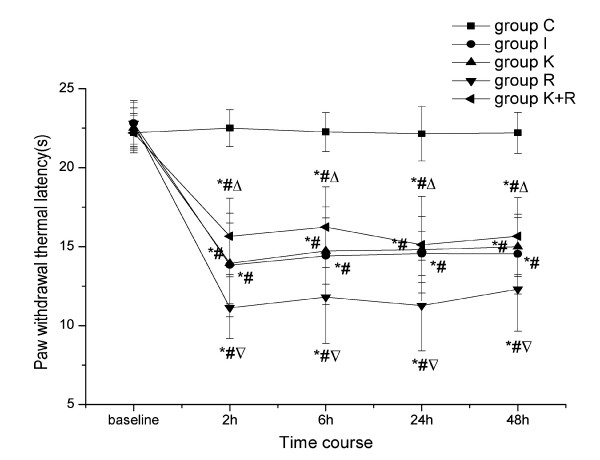
Effects of remifentanil on PWTL during the postoperative period and the intervention of ketamine. Ketamine (10 mg/kg, 0.1 ml) or saline was subcutaneously injected 30 min before surgery. Under sevoflurane anesthesia, remifentanil (0.04 mg/kg, 0.4 ml) or saline was subcutaneously infused in the absence or presence of the right hind paw incision during a period of 30 min. PWTL was evaluated at 24 h before incision and at 2 h, 6 h, 24 h and 48 h after surgery. Number of rats per group was twelve. Data are expressed as means ± SD. * P < 0.01 vs baseline, # P <0.01 vs group C, ▽P <0.05 vs group I, △P < 0.01 vs group R.